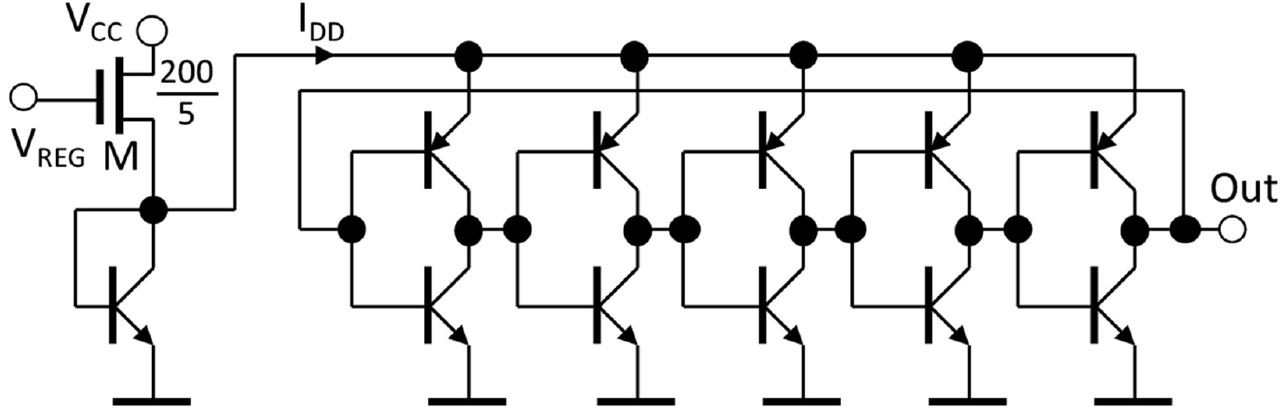
Figure 20. Five-stage CBip ring oscillator with supply voltage controlled by a NMOS transistor M.